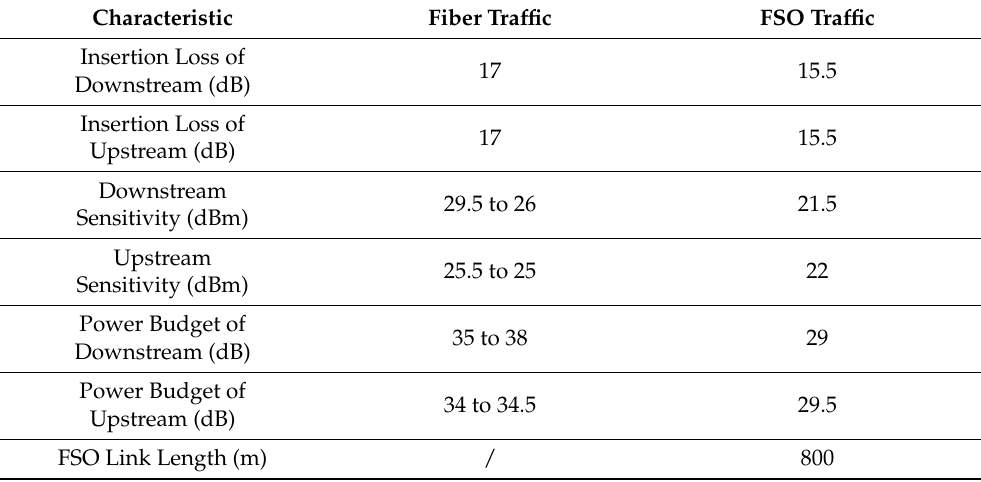
Table 1. The corresponding results of fiber and FSO signal performances.